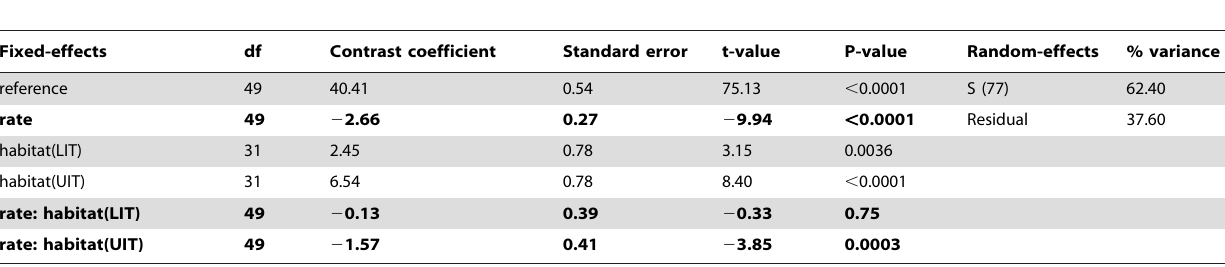
Table 2. Summary of minimum adequate linear mixed effects (lme) model results for upper lethal temperature (ULT) as a function of log 10 (experimental rate of temperature change) and habitat (subtidal, low intertidal and upper intertidal).